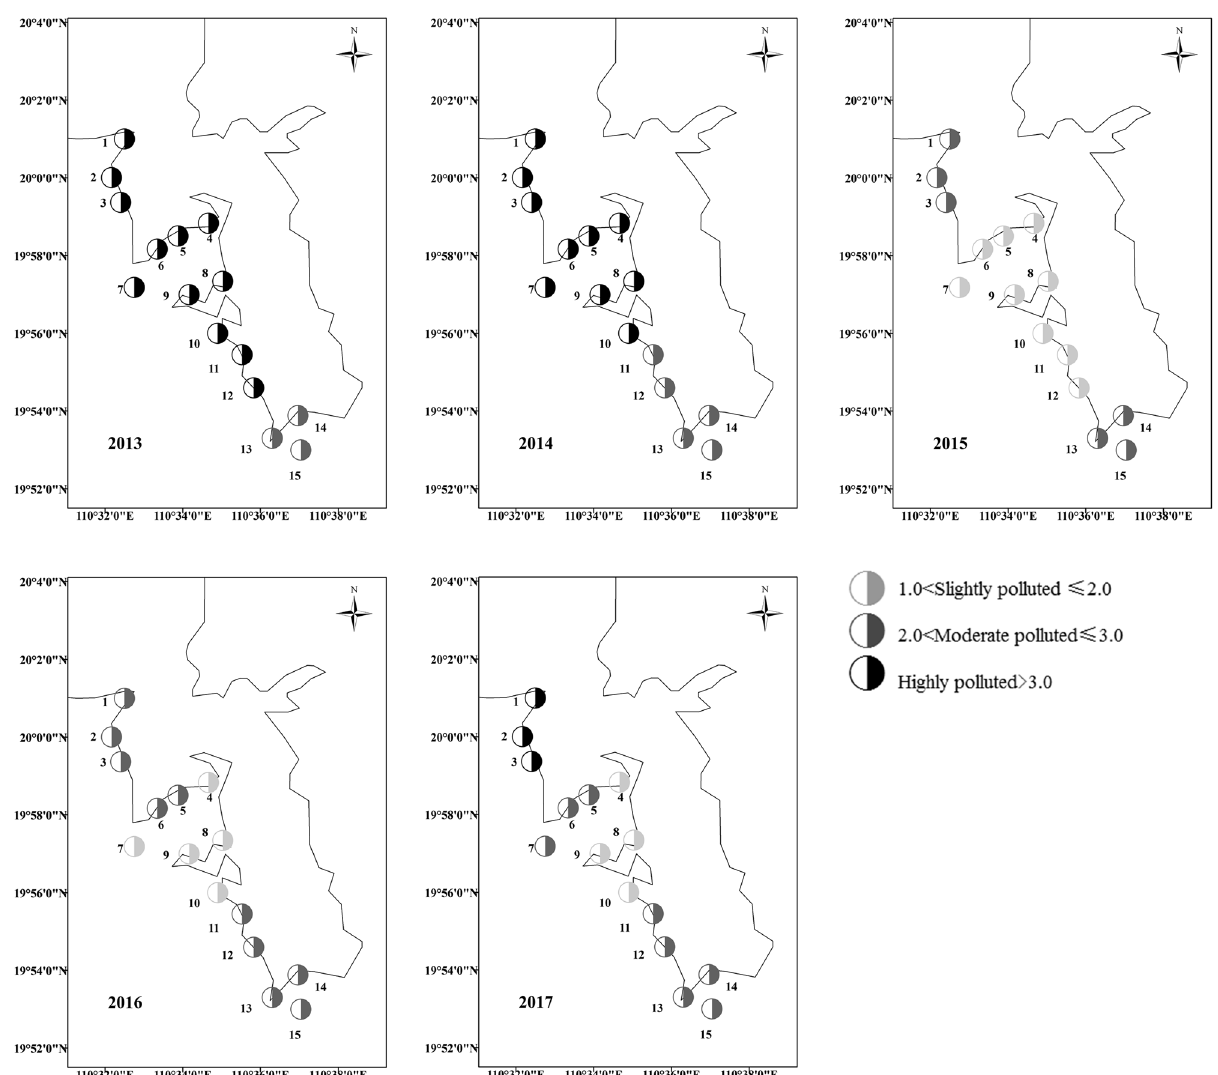
Fig. 5 Nemerow’s pollution index for each sampling point along Dongzhai harbor from 2013 to